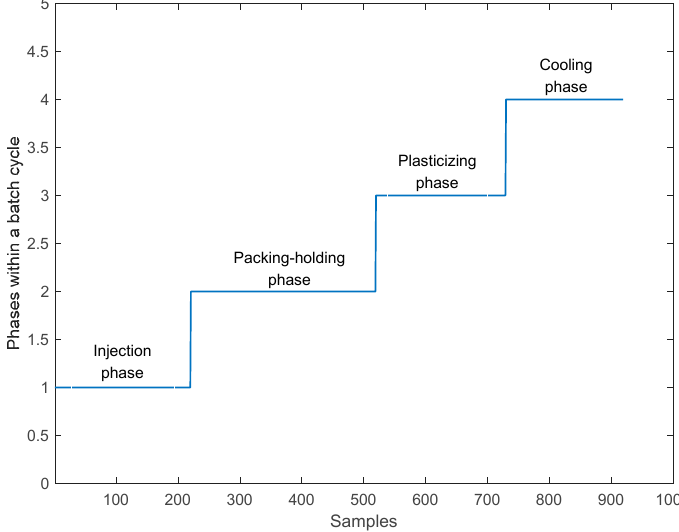
Figure 6. Final result of phase division in injection molding process.